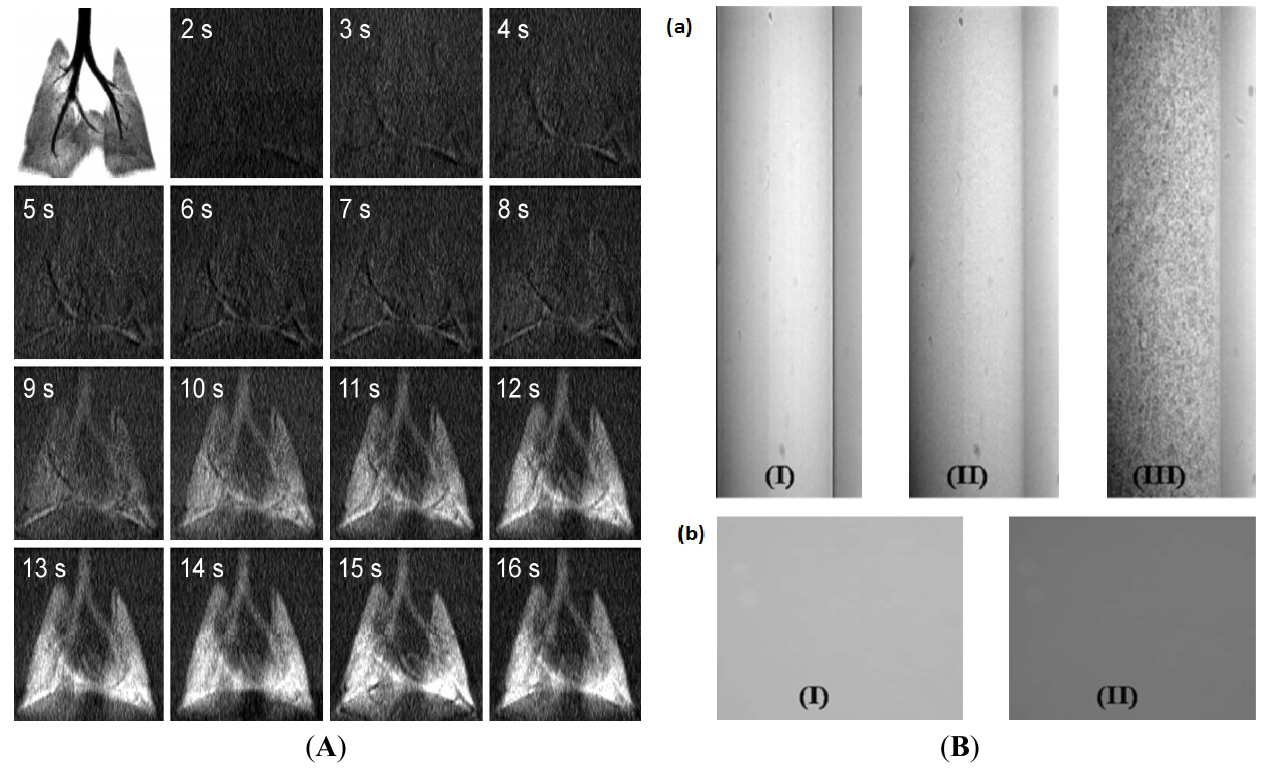
Figure 2. ( A ) A dynamic flat-panel volumetric preclinical micro-CT scanner (eXplore Ultra, GE Healthcare, London, ON, Canada) images of rat lungs. Top left frame shows a minimum intensity projection of an oxygen-filled rat lung. Subsequent frames show the evolution of Xe with baseline image subtracted at 1s intervals. The field-of-view for each frame is 36.5 mm × 36.5 mm [36] ( B ) ( a ) Typical X-ray images of an (I) empty tube (II) blood flow, and (III) blood flow seeded with Iopamidol-incorporated microparticle inside the tube. ( b ) Comparison of absolute X-ray absorption of (I) stationary pure blood and (II) blood mixed with pure iopamidol. Images are obtained by 3 rd generation synchrotron X-ray source with unmonochromated beamline (bending magnet; energy range of 4–15 keV) [40]. Adapted by permission from the American Physiological Society and